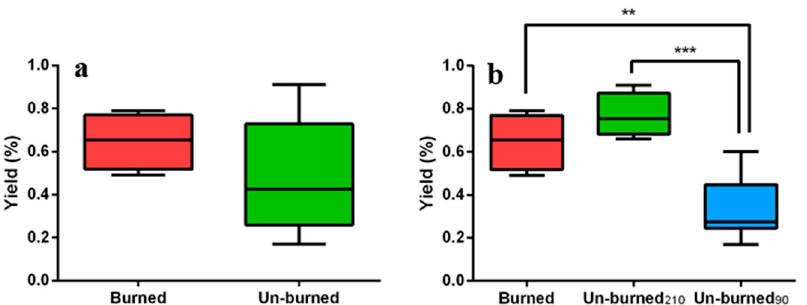
Figure 3. Box plots showing the yield values for burned and un-burned samples ( a ) and for burned vs. un-burned samples subject to microwave irradiation for 90 or 210 min ( b ). The two groups in panel A were compared with an unpaired t -test, while the three groups of panel B were compared with ANOVA followed by Tukey’s HSD test. The significance was reported in terms of the p -value as follows: no asterisks for p > 0.05; * for 0.05 < p < 0.01; for ** 0.01 < p < 0.001; *** for p < 0.001. The horizontal line within the box is the median value, while the whiskers represent the maximum and minimum values recorded; the top of the rectangle indicates the third quartile, while the bottom of the rectangle indicates the first quartile.